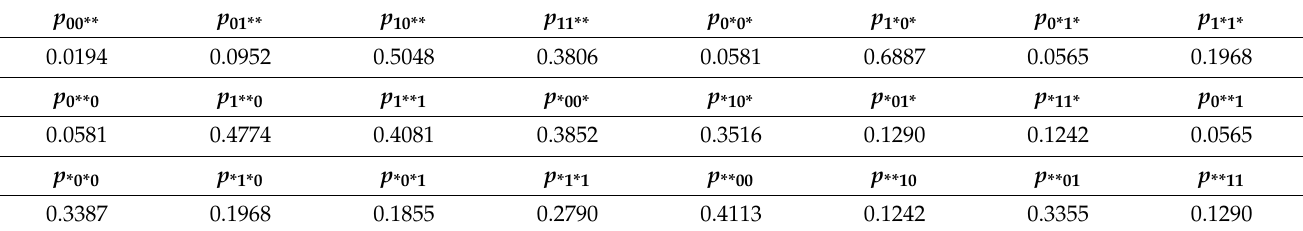
Table 6. Two-factor change probability of marine accidents.